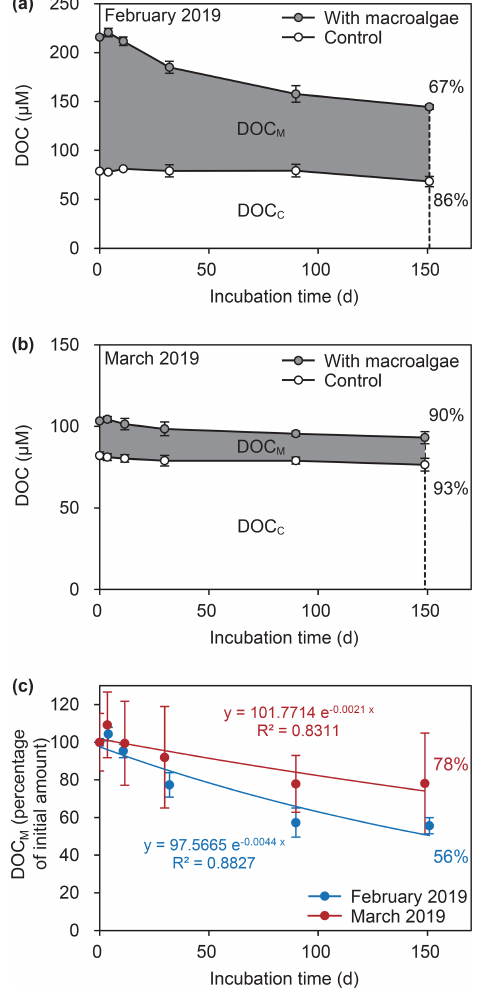
Figure 6. Time course of dissolved organic carbon (DOC) con- centrations during the degradation experiments in (a) February and (b) March and (c) percentage of DOC derived from macroal- gae (DOC M ) during both experiments. Shading indicates the con- centration of DOC M , which was equated to the difference between the DOC concentration in the macroalgae bag and the DOC con- centration in the control bag (DOC C ). Percentages in panels (a) and (b) are averaged final percentages of DOC remaining in each treatment after 150d.